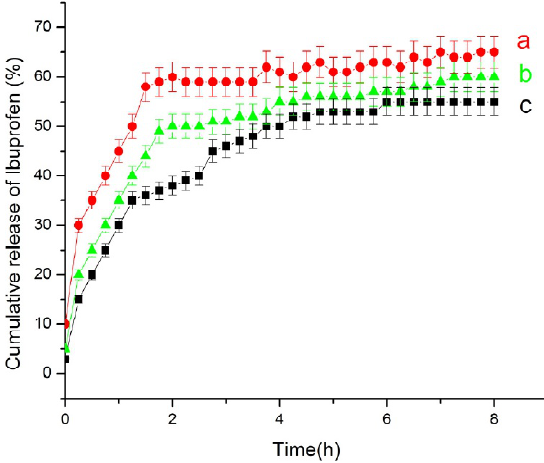
Fig. 7. Cumulative release profiles of ibuprofen re- lated to encapsulation efficiency (E.E) of a) SiO Mag-IBU (1:24), b) SiO Mag-IBU (1:8) samples.